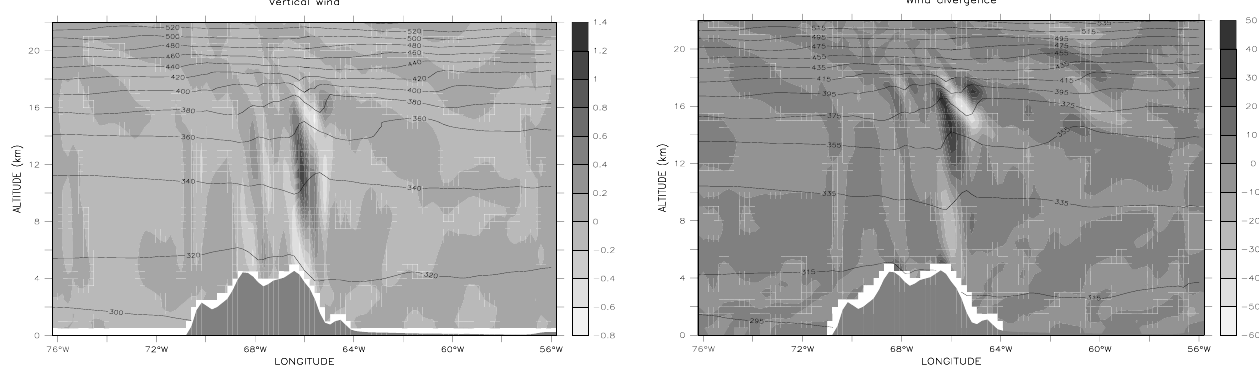
Fig. 18. Case 3: Results of the WRF simulations. Mountain wave detection in the Salta region. Longitude-altitude cross sections at latitude − 24.81N (Salta latitude). Left: Vertical wind velocity (ms − 1) and isentropes (K). Right: Horizontal wind divergence (s − 1) and isentropes (K).